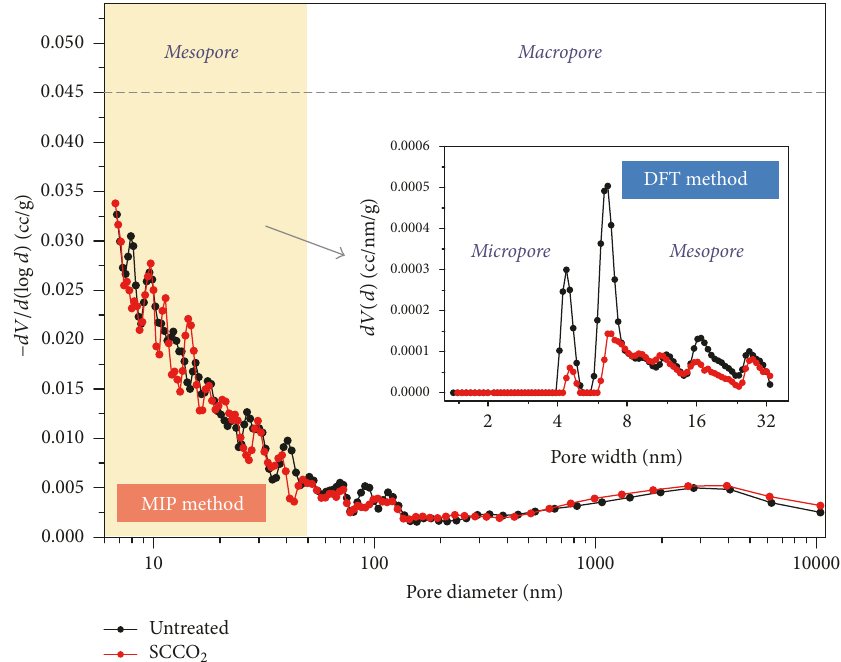
Figure 5: Pore size distribution of untreated and SCCO 2 -treated oil shale from the MIP and DFT method.